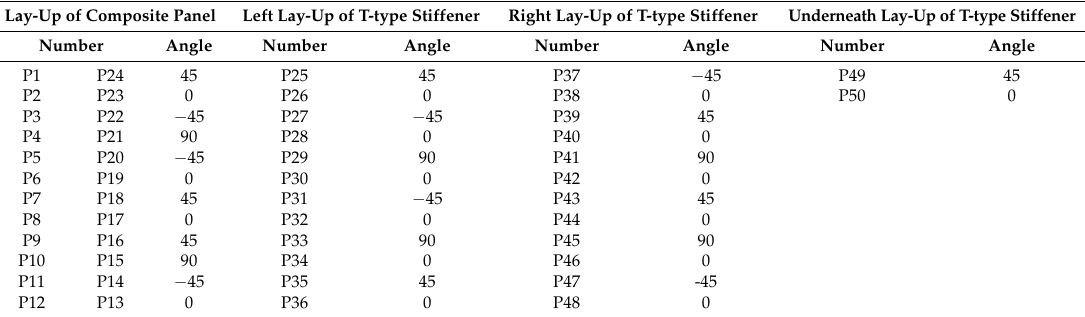
Figure 2. Lay-up profile of composite-reinforced panel. Table 1. Lay-ups of the composite-reinforced panel.